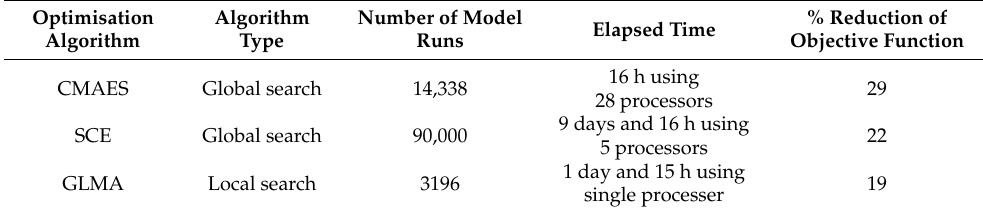
Table 2. Calibration run summary using different optimisation